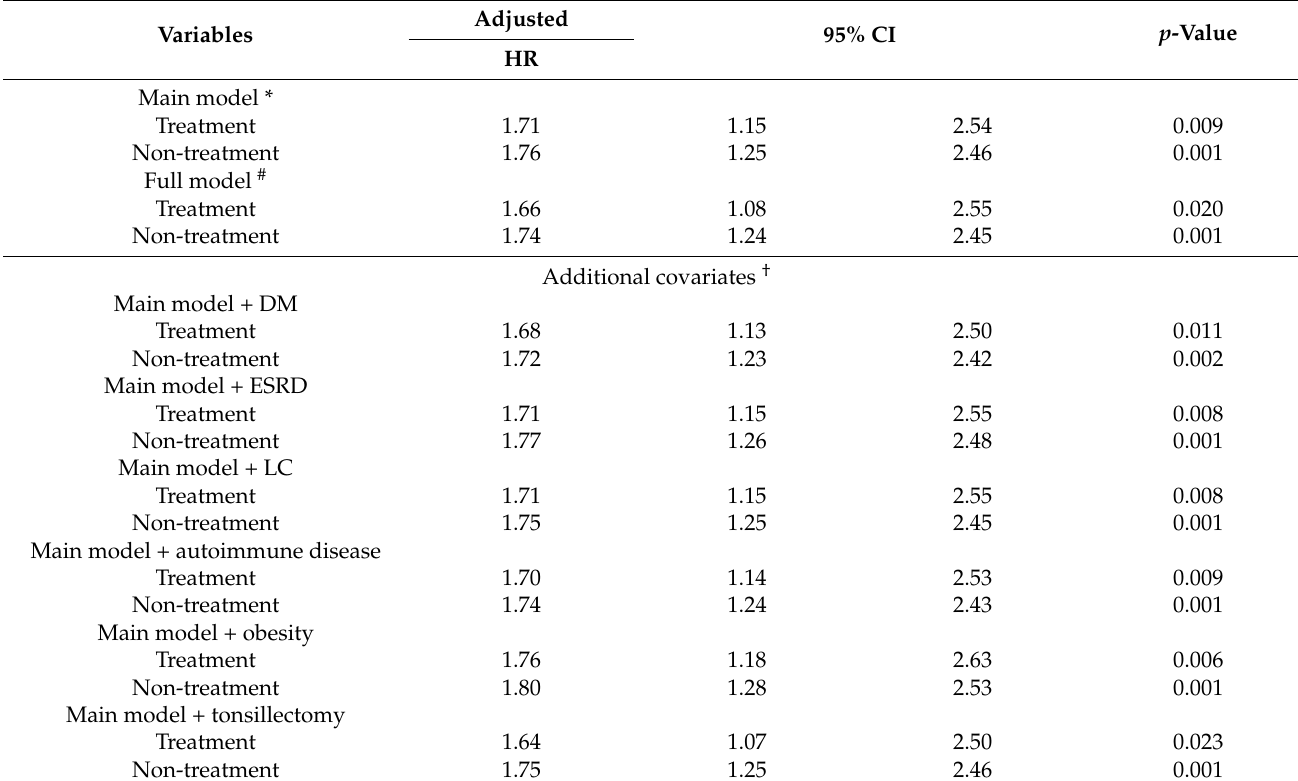
Table 3. Multivariable Cox proportional hazard model for DNI risk in sleep apnea patients with and without treatment. Variables